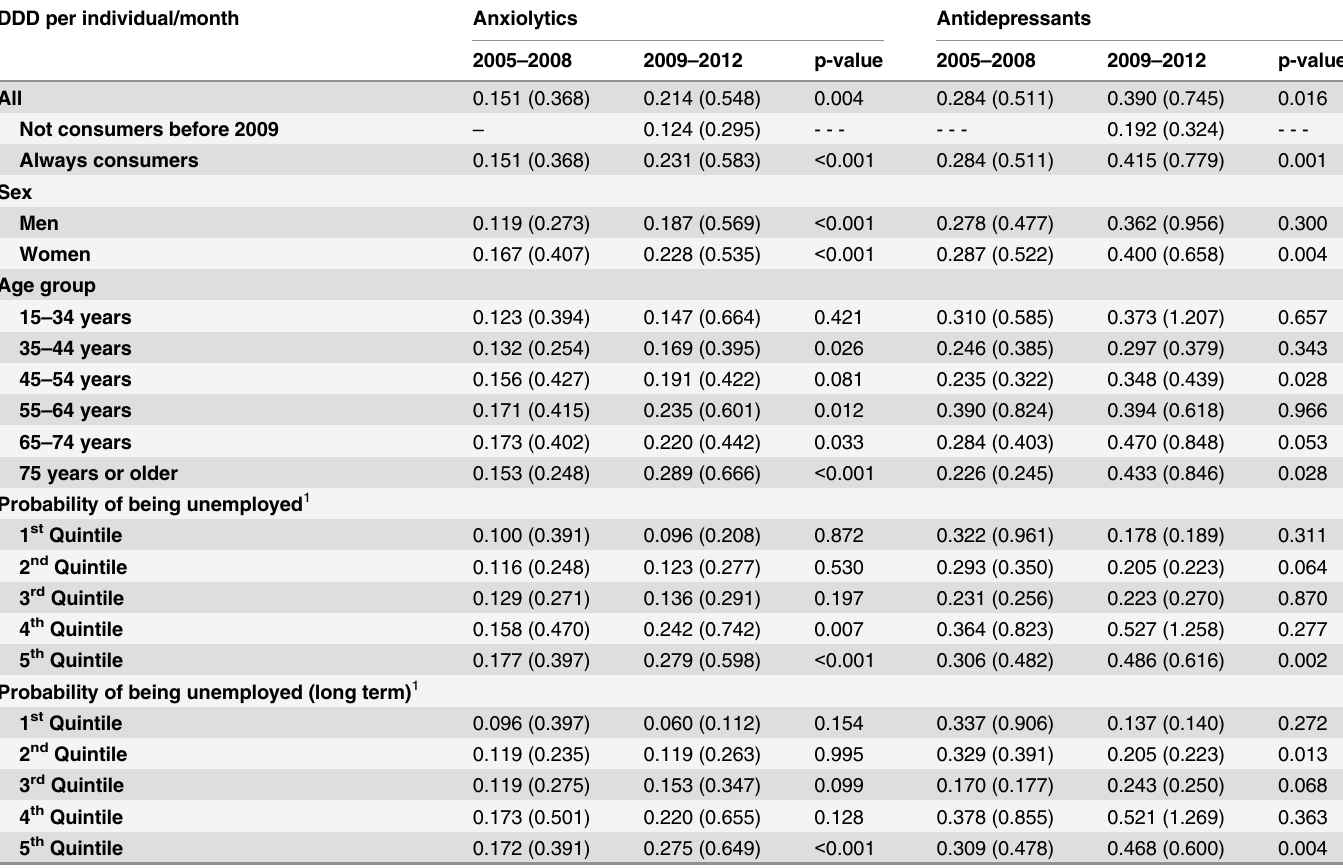
Table 5. Consumption of psychotropic drugs. DDD per